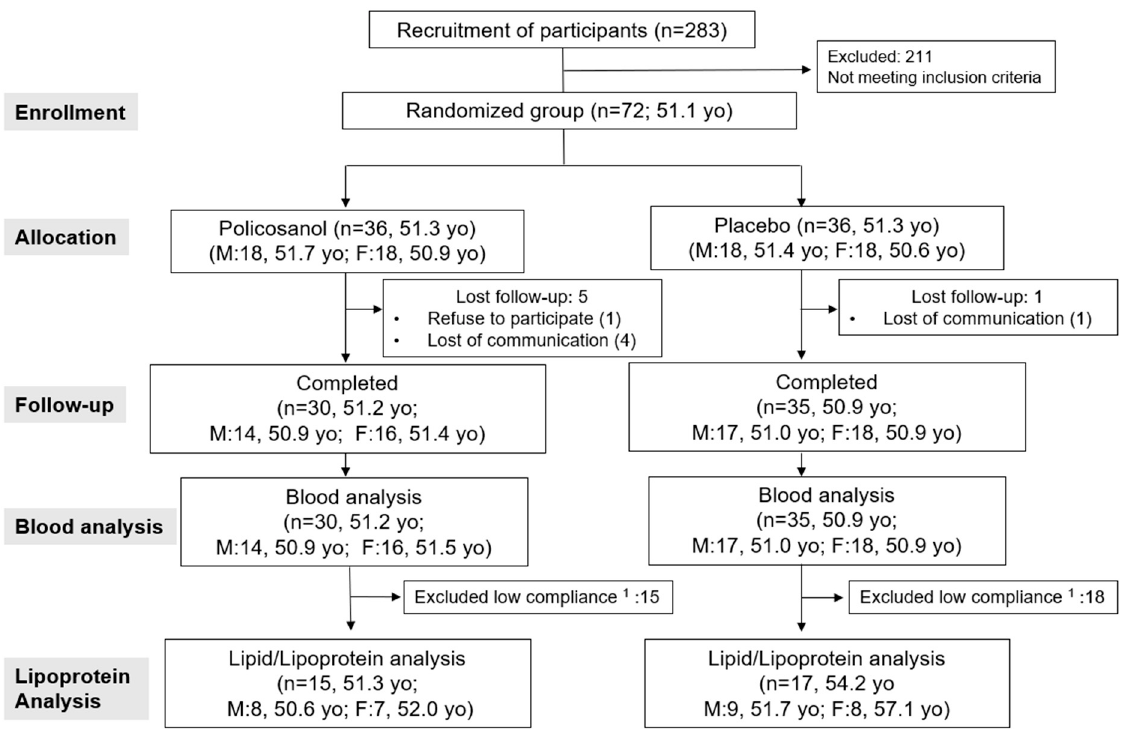
Figure 10. Study design and participant allocation for analysis. 1 The participants were excluded